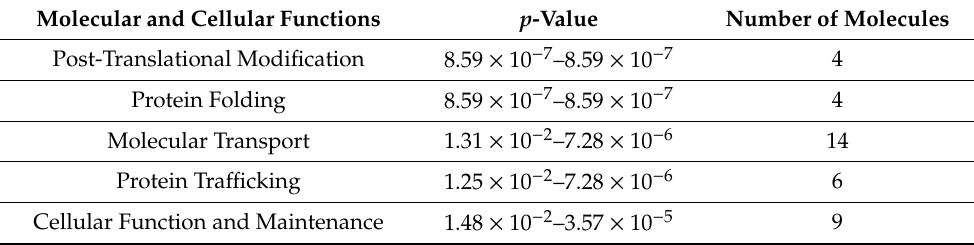
Table 2. List of top molecular and cellular functions analyzed by Ingenuity Pathway Analysis (IPA). Molecular and Cellular Functions p